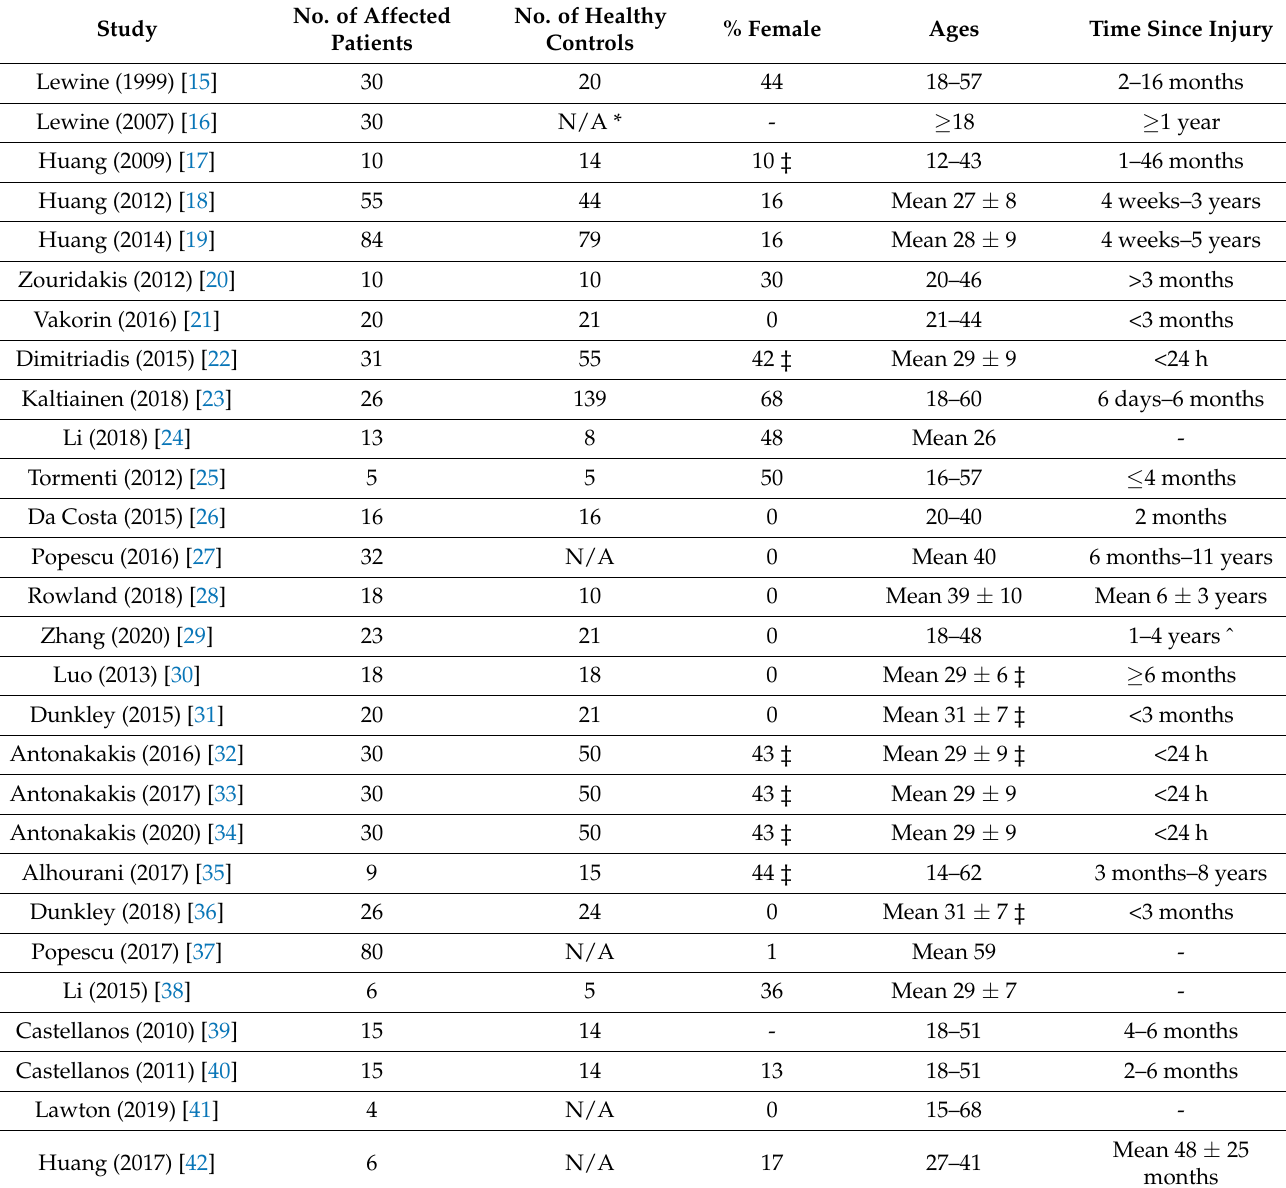
Table 1. Participant demographics for each study, listed in the order referenced. Sets are ranges unless otherwise specified with “mean.” Fields marked with a hyphen indicate the information was not available. “N/A” indicates “not applicable.” * Retrospective review. ‡ Applies to affected patient group only. ˆ Indicates years with post-traumatic stress disorder symptoms as opposed to years since traumatic brain